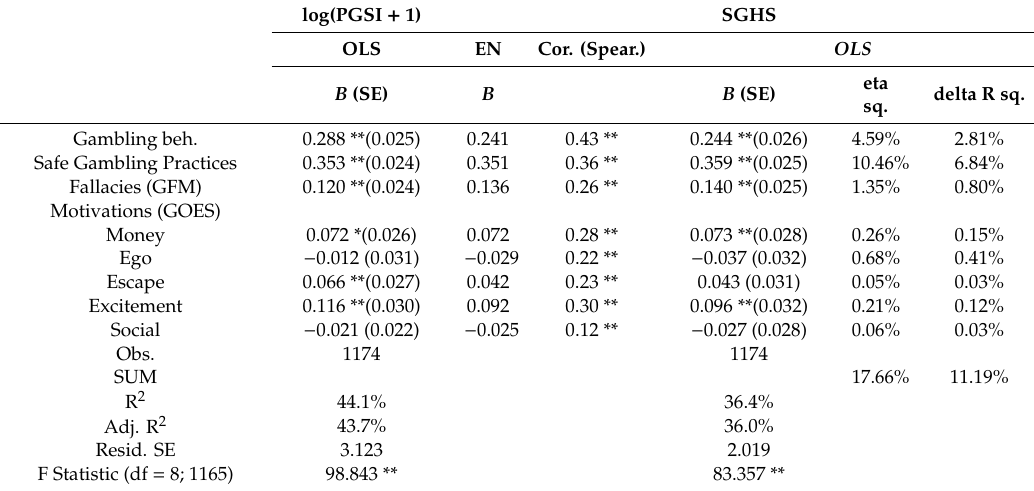
Table 3. Bivariate correlations, OLS and EN multivariate regressions of proximal risk factors on gambling-related harm, and OLS multivariate regression of proximal risk factors on PGSI. log(PGSI + 1) SGHS OLS EN Cor. (Spear.) OLS eta B (SE) B B (SE) delta R sq. sq. Gambling beh. 0.288 **(0.025) 0.241 0.43 ** 0.244 **(0.026) 4.59% 2.81% Safe Gambling Practices 0.353 **(0.024) Money 0.072 *(0.026) 0.072 0.28 ** 0.073 **(0.028) 0.26% 0.15% Ego − 0.012 (0.031) − 0.029 0.22 ** − 0.037 (0.032) 0.68% 0.41% Escape 0.066 **(0.027) 0.042 0.23 ** 0.043 (0.031) 0.05% 1174 1174 SUM 44.1% 43.7% 83.357